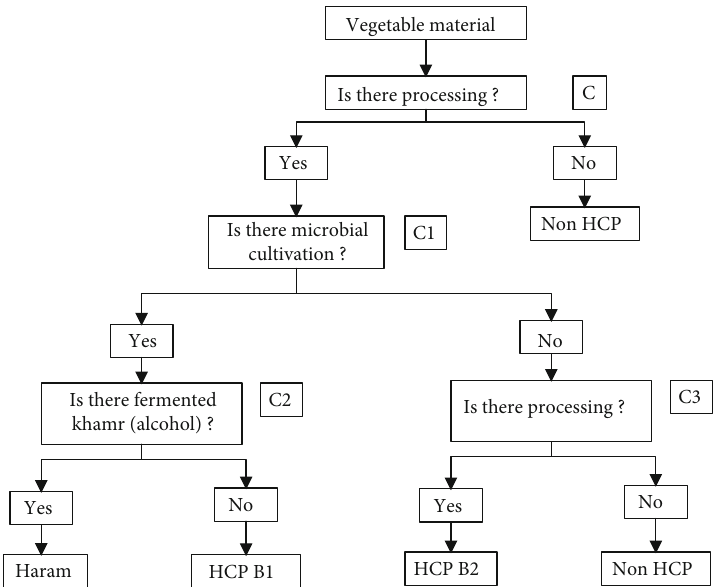
Figure 2: Decision tree for identi fi cation of Halal Control Points for vegetable materials (Source: [21]). The explanation is as follows: c: list of questions for vegetable materials; number: question